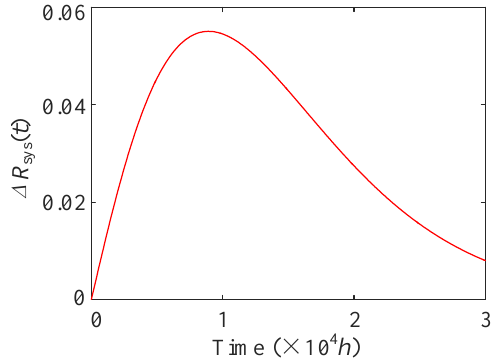
Figure 11. Improvement of system reliability with component swapping.